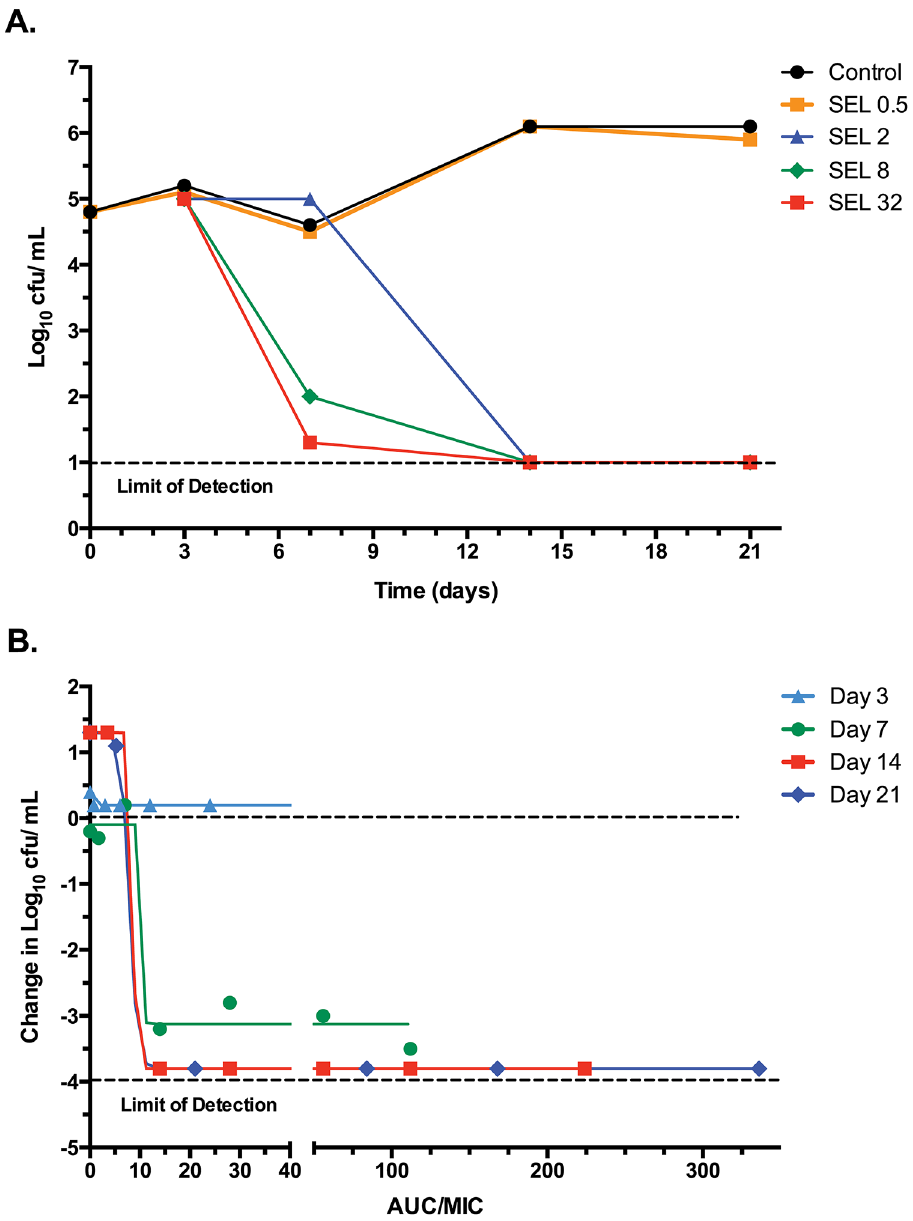
Fig 2. Kill kinetics of selamectin against M . ulcerans S1013. Dose response kill kinetic assays were plotted based on ( A ) drug concentration and ( B ) incubation time. AUC is the concentration of selamectin multiplied by the time of exposure (AUC = C SEL x T days ). AUC, area under the curve. SEL, selamectin. Concentrations are in μ